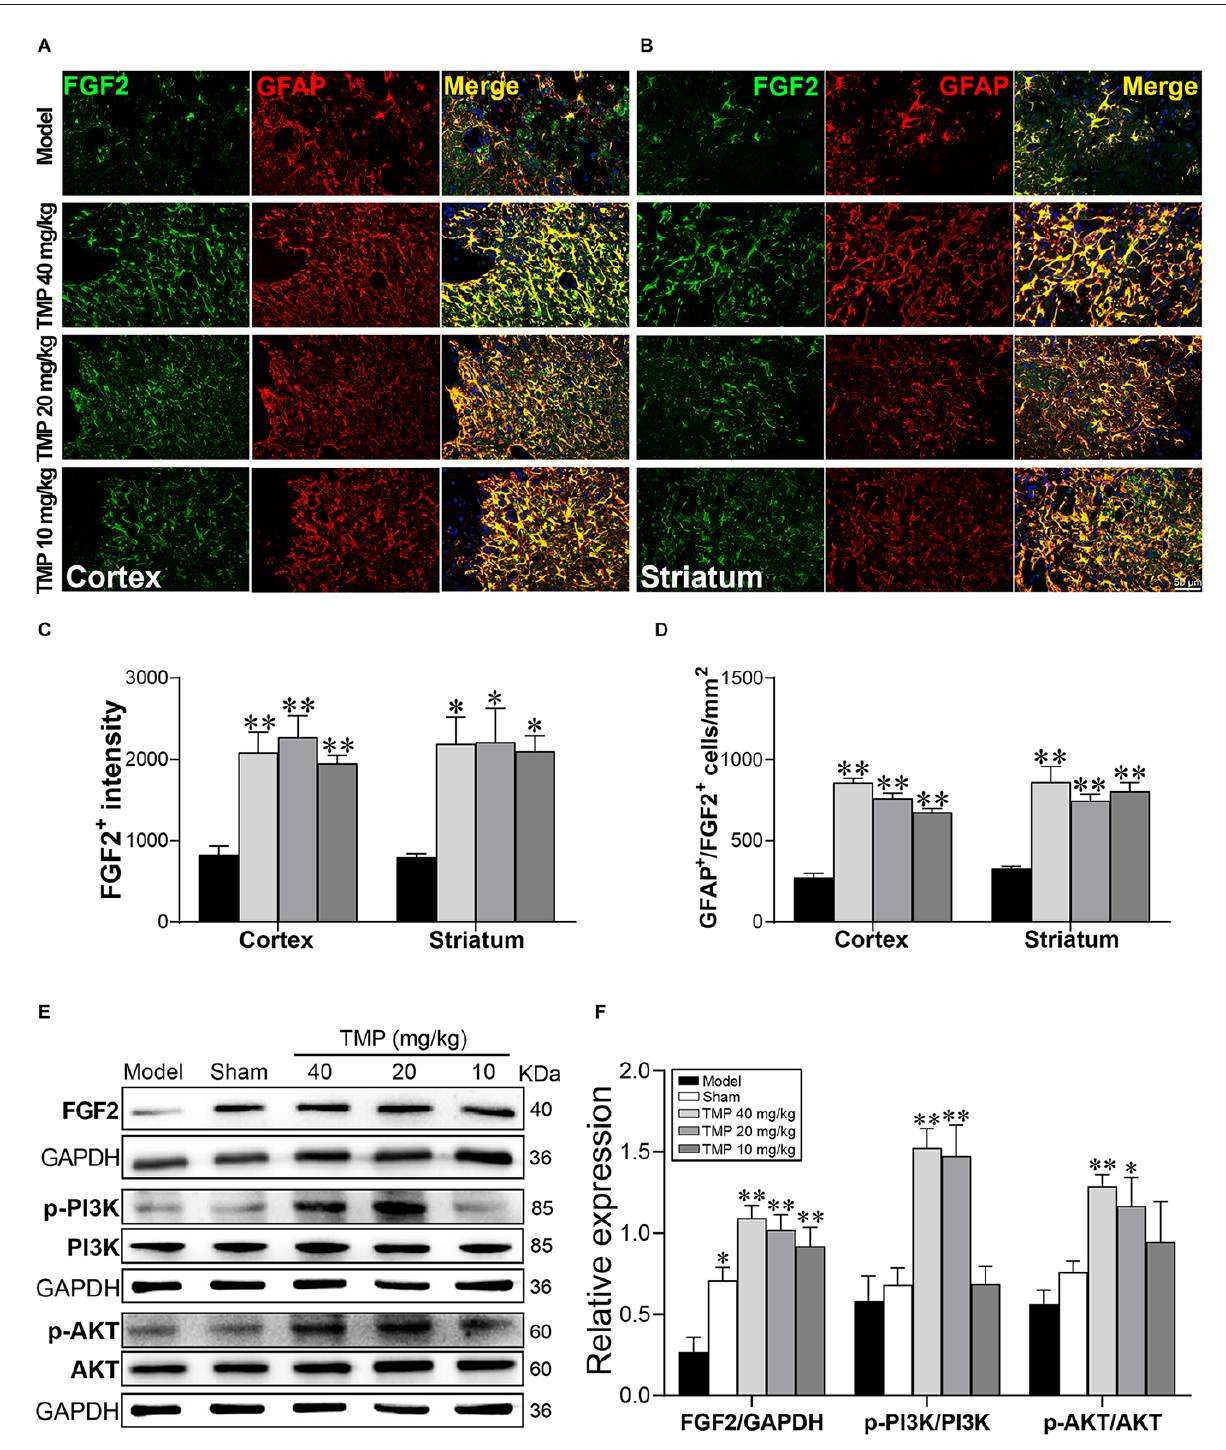
FIGURE8 TMP increased FGF2 expression in astrocytes and activated PI3K/AKT/FGF2 pathway in MCAO rats. Immunofluorescence images showed co-localization of FGF2 (green) and GFAP (red)-stained astrocytes in (A) the periinfarct cortex and (B) striatum. Merge (yellow) indicated GFAP/FGF2 co-labeling cells and DAPI (blue) indicated cell nuclei. Quantification of (C) FGF2 + intensity and (D) GFAP + /FGF2 + cells in the periinfarct cortex and striatum of Model and TMP groups ( n = 4). (E,F) Western blot analysis for FGF2, PI3K, and AKT in the periinfarct cortex ( n = 4). ∗ P < 0.05, ∗∗ P < 0.01 vs. Model